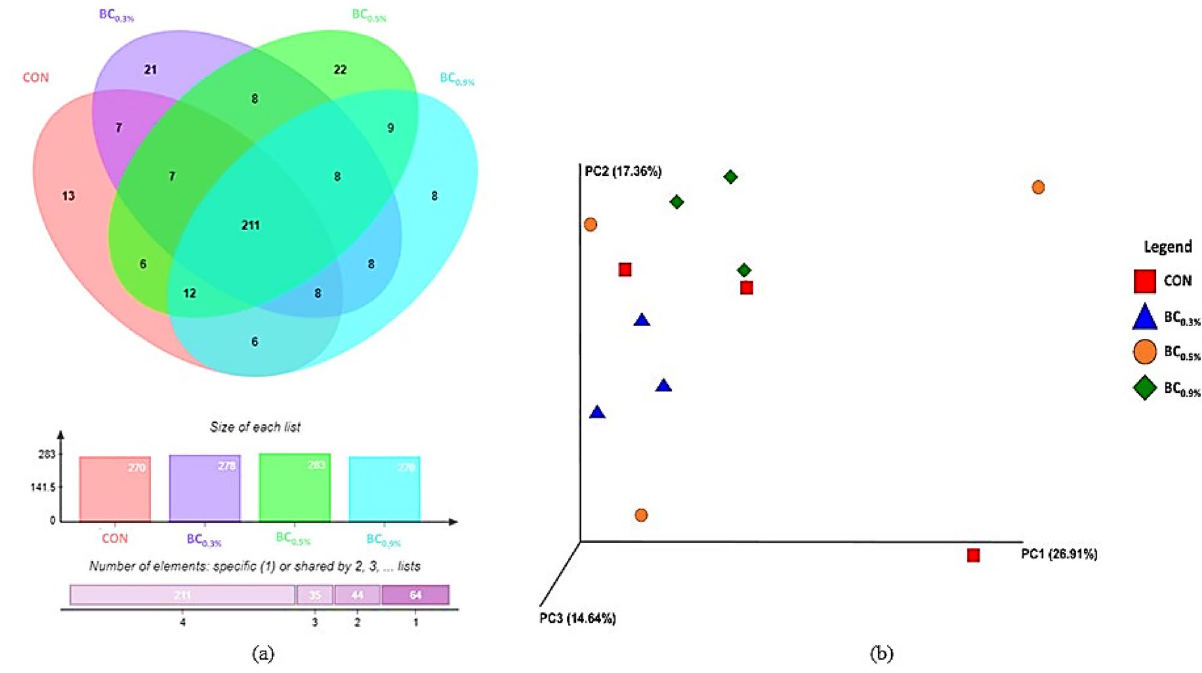
Figure 3. ( a ) Membership-based representation of unique, shared and core bacterial community of rumen microbiome after treatment supplementation with varying level of buffering capacity, and the total size of observed species per treatment. Venn diagram was generated in MetaCOMET 24 using jvenn 26 . ( b ) Principal Coordinate Analysis (PCoA) of all samples using Bray–Curtis distance derived from the subset of identified OTUs. PCoA plot was generated using EMPeror 27 . CON (no buffer added); BC 0.3% (0.3% buffer); BC 0.5% (0.5% buffer); BC 0.9% (0.9%